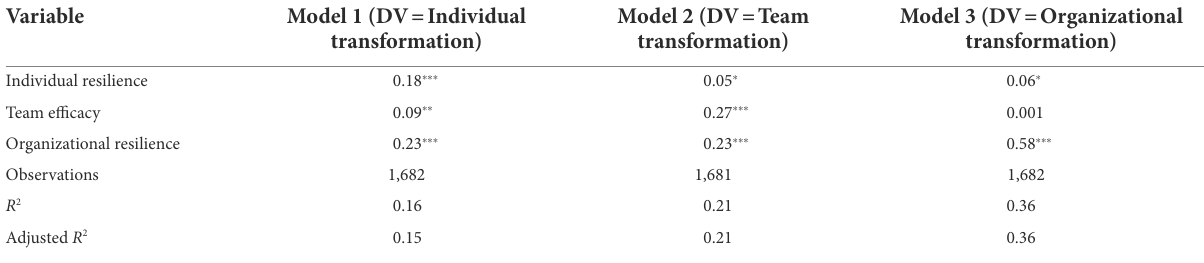
TABLE 2 Individual resilience, team efficacy, and organizational resilience as determinants of perceptions of transformation. Variable Individual